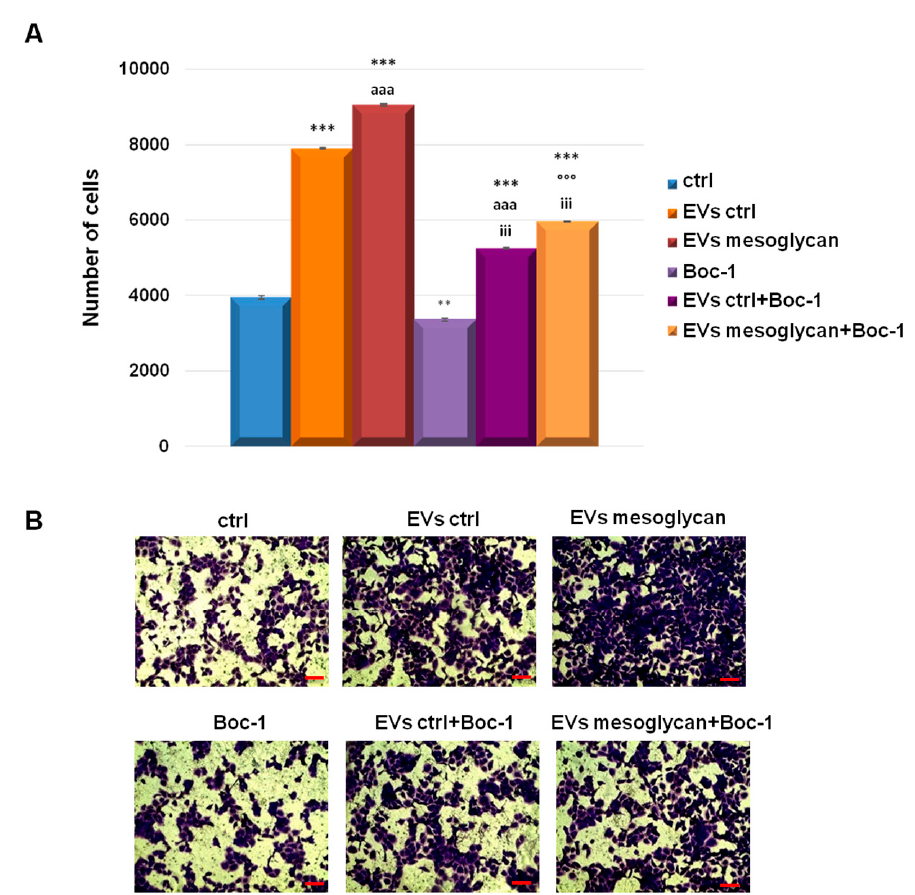
was administrated together with the two kinds of EVs. These results were represented with the histogram in Figure 6A and the related bright filed images in Figure 6B.